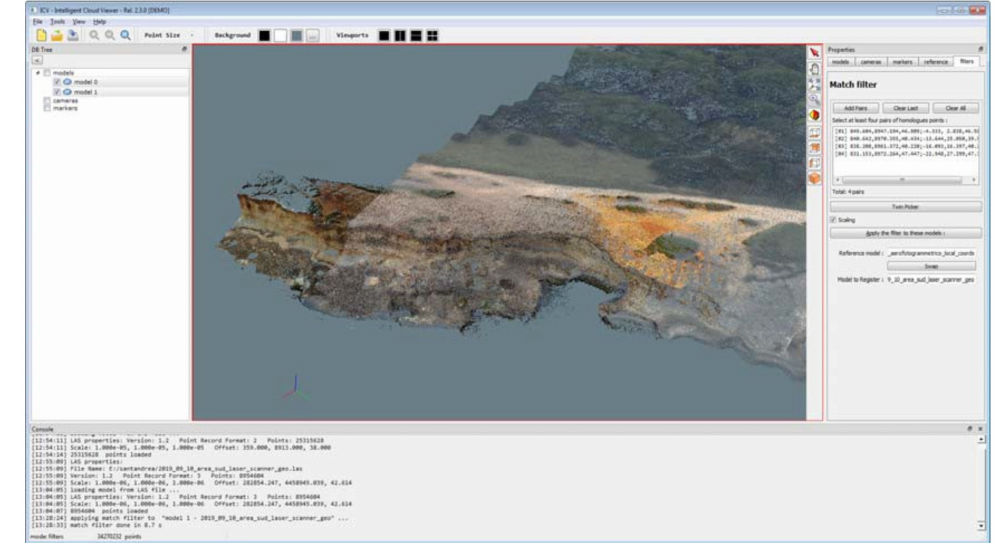
Figure 10. Result of course registration